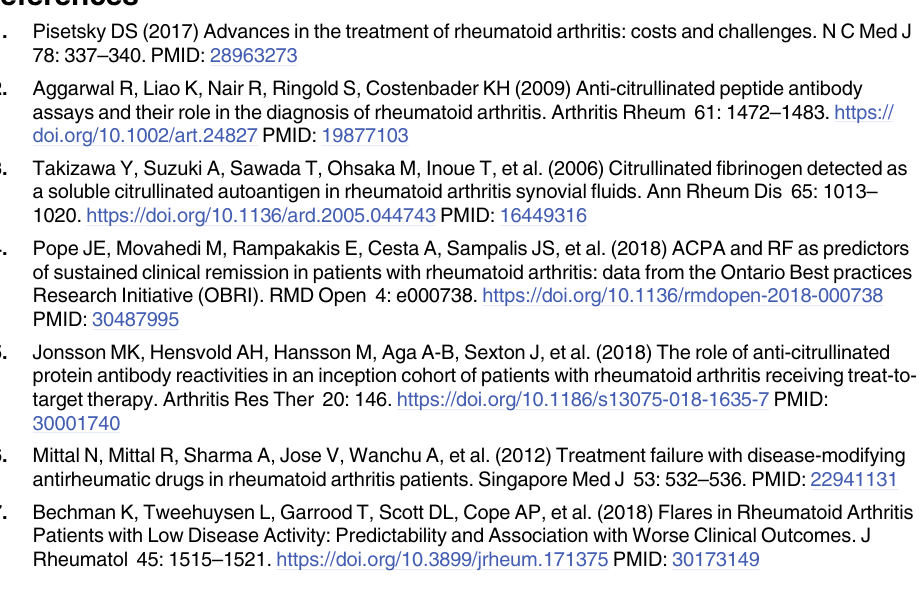
S9 Appendix. Joint count correlation study; data for individual patients. S13. Table. Data for RA individuals applied in joint count correlation